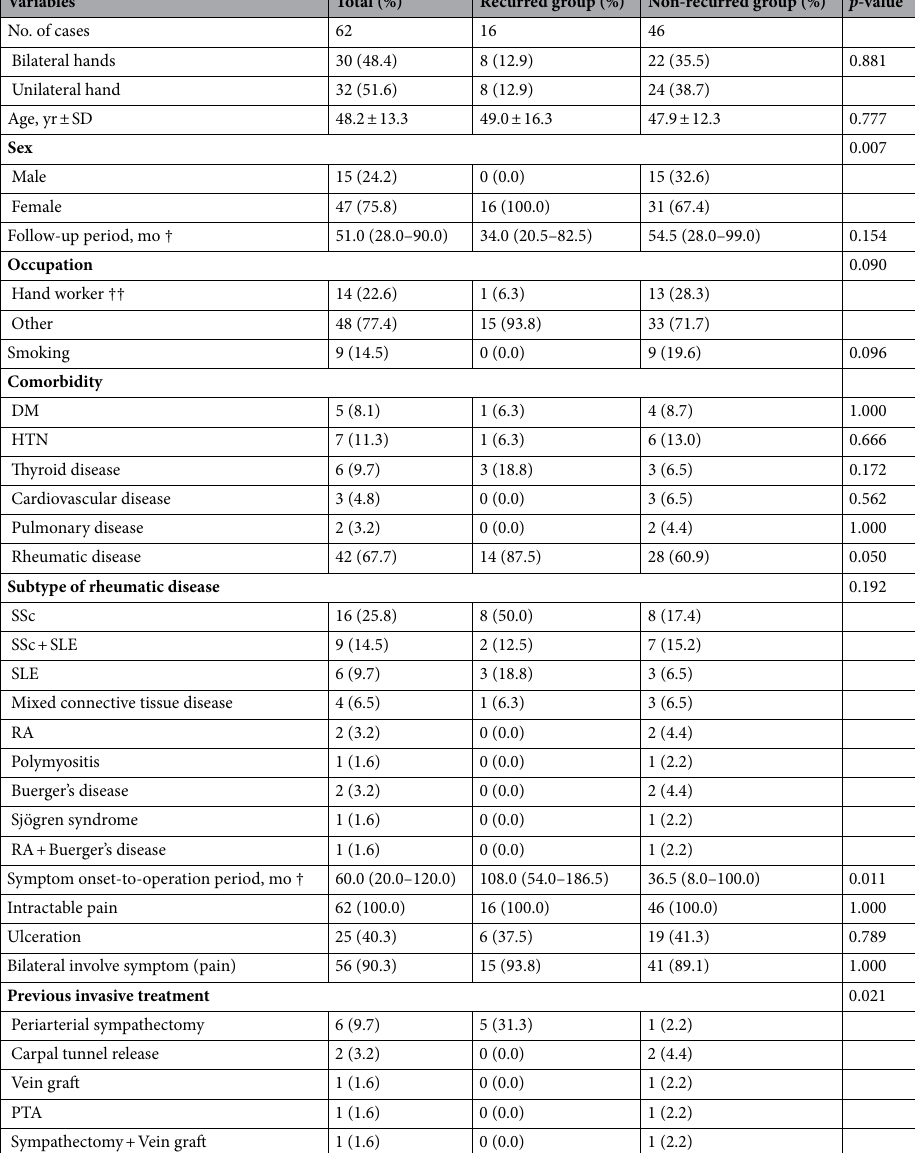
Table 1. Demographic Characteristics of All Study Cases. SD, standard deviation; DM, diabetes mellitus; HTN, hypertension; SLE, systemic lupus erythematosus; RA, rheumatoid arthritis; PTA, percutaneous transluminal angioplasty. † Median, mo (interquartile range). †† Hand workers refer to patients with jobs that have high exposure to vibrating hand-held tools, such as miners, construction workers, or